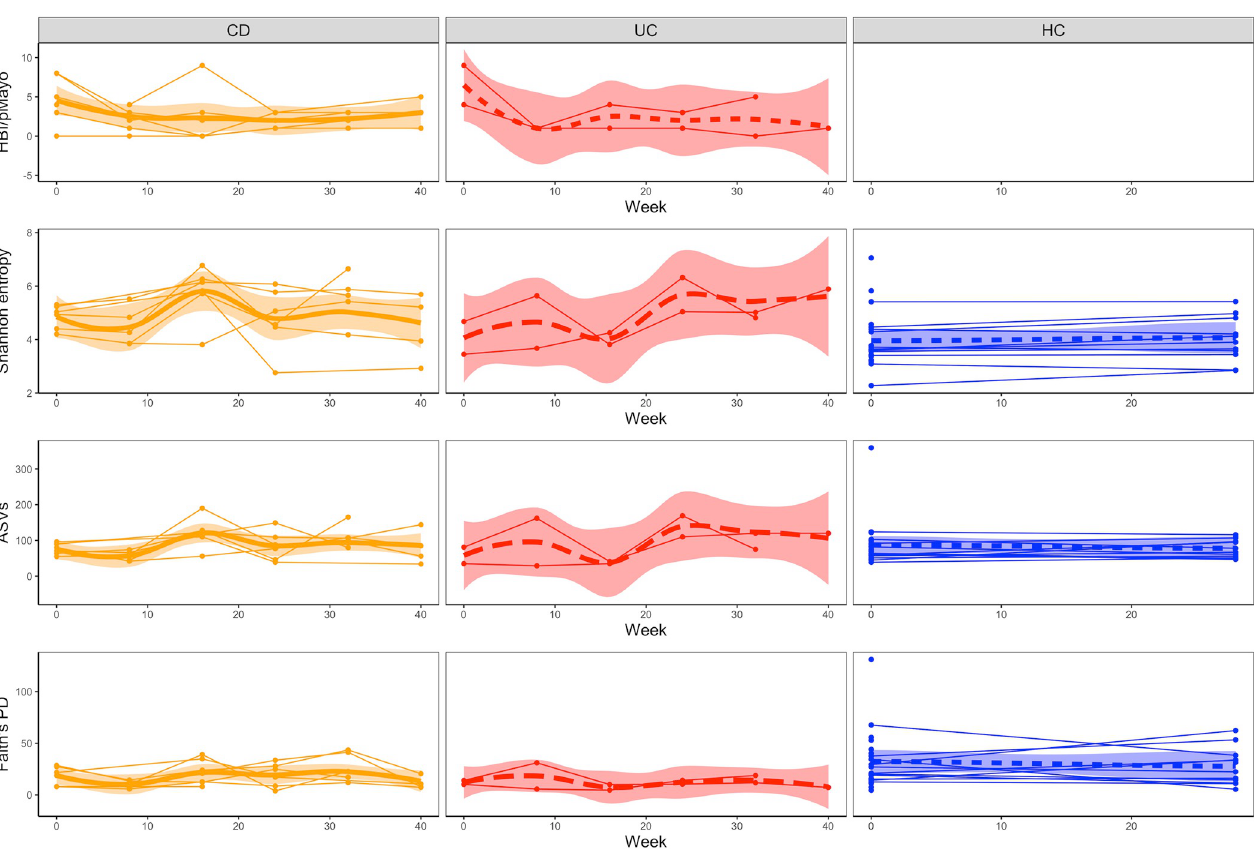
Fig 5. Temporal changes in different alpha diversity metrics of the skin microbiome of healthy controls, patients with Crohn’s disease, and patients with ulcerative colitis during 40 weeks of ustekinumab therapy. The line charts show changes in disease activity scores, Shannon entropy, Chao1 diversity estimator, number of observed ASVs, and Faith’s phylogenetic diversity over time for patients with Crohn’s disease, patients with ulcerative colitis, and healthy controls. Each line represents one individual, the bold lines represent locally weighted regression with a confidence interval fill. (HBI) Harvey-Bradshaw Index, (pMayo) partial Mayo score, (PD) phylogenetic